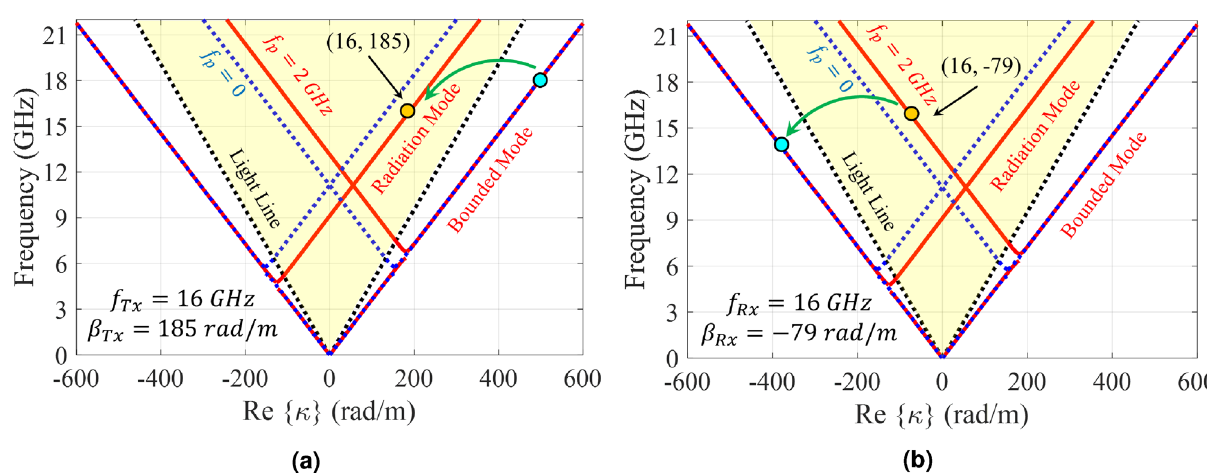
Figure 7. Dispersion diagram of the proposed spatio-temporally modulated hologram for the case of f p = 2 GHz in ( a ) transmission mode, and ( b ) receiving